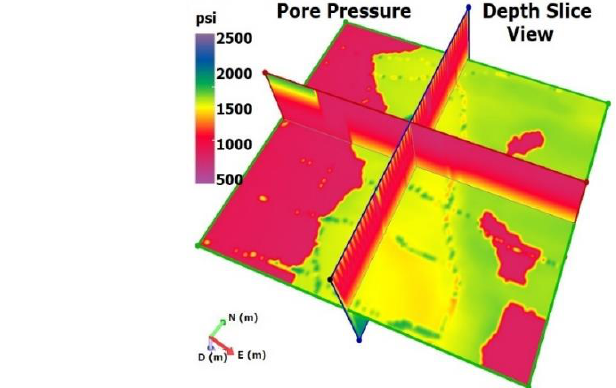
1040 | Vol. 6, No. 4, 2021